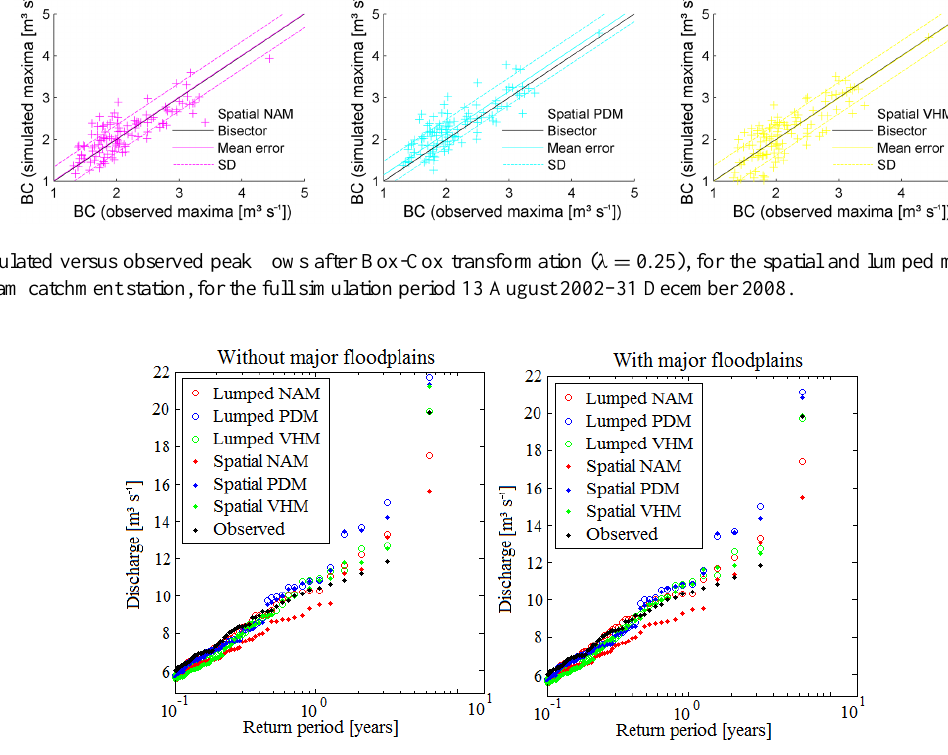
Figure 4. Simulated versus observed peak flow frequency distributions, for the spatial and lumped models at the Grote Nete downstream catchment station, for the full simulation period 13 August 2002–31 December 2008, with and without the effect of the three floodplains with highest